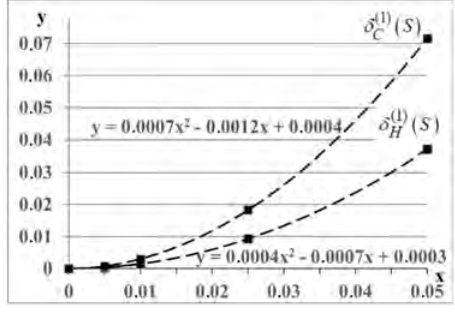
( S ) , δ (1) ( S ) , - - - graphs of H C